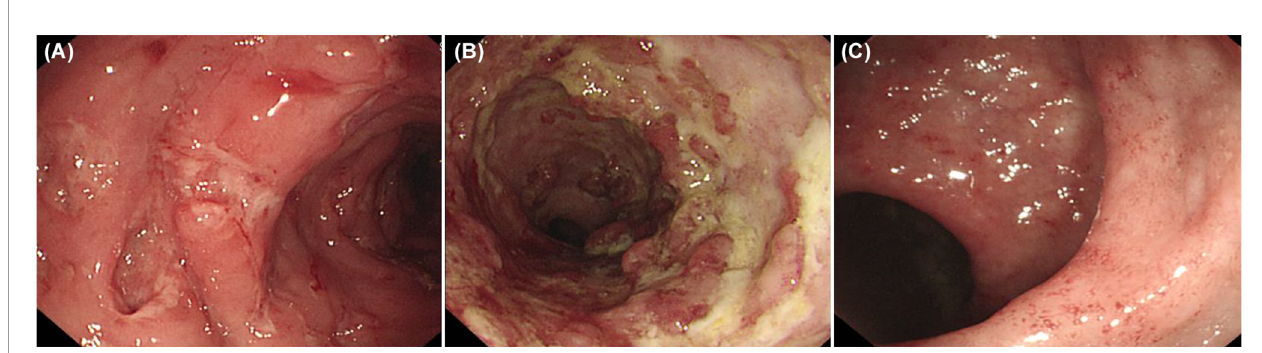
FIGURE 3 | In fl ammatory bowel disease like colitis in patients with primary immunode fi ciency. (A) Multiple large deep ulcers on whole colon in a patient with X-linked inhibitor of apoptosis protein de fi ciency. (B) Longitudinal large deep ulcer on whole colon in a patient with Chronic recurrent multifocal osteomyelitis.